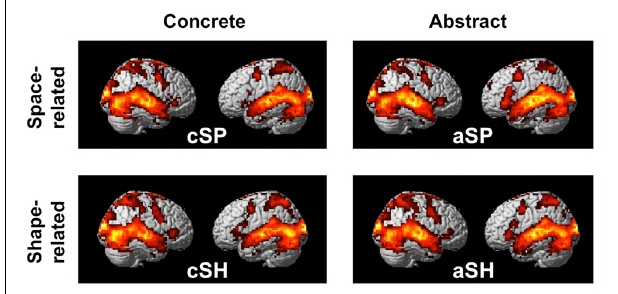
FIGURE 2 | Activation pattern in contrast to baseline (whole-brain, p < 0 . 005, cluster extend threshold = 8 voxels; MC corrected p < 0 . 05).